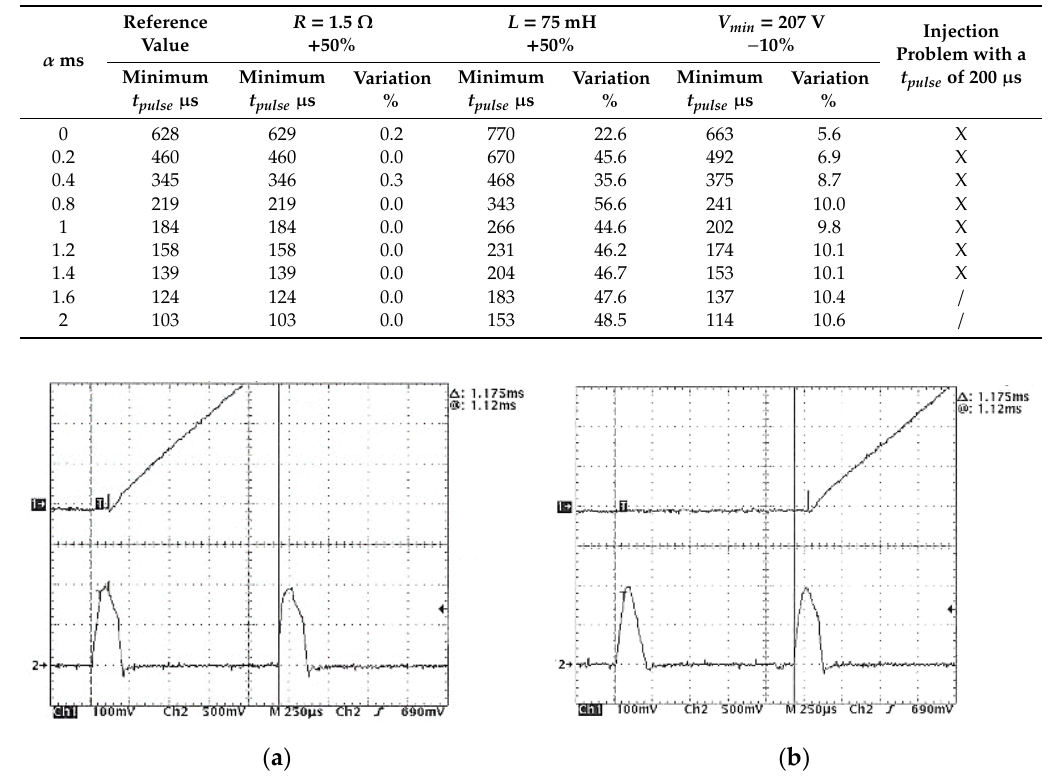
Table 4. Conduction delay due to load and voltage variation.